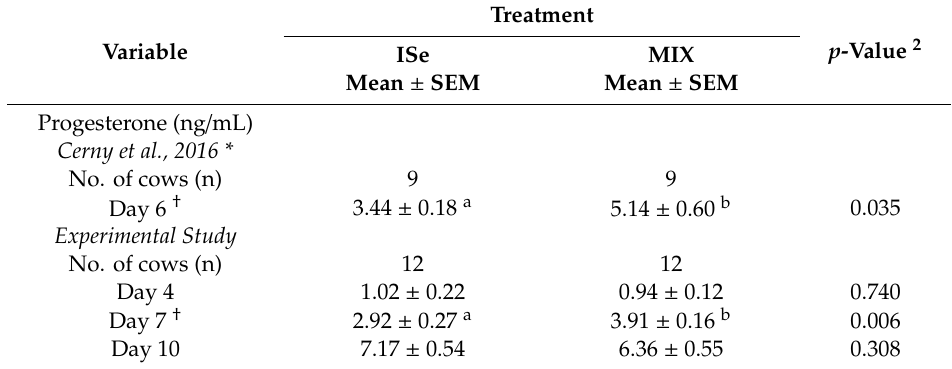
Table 1. E ff ect of the form of supplemental Se on the concentration of progesterone (P4) in the peripheral plasma of cows during the early luteal phase of the estrous cycle